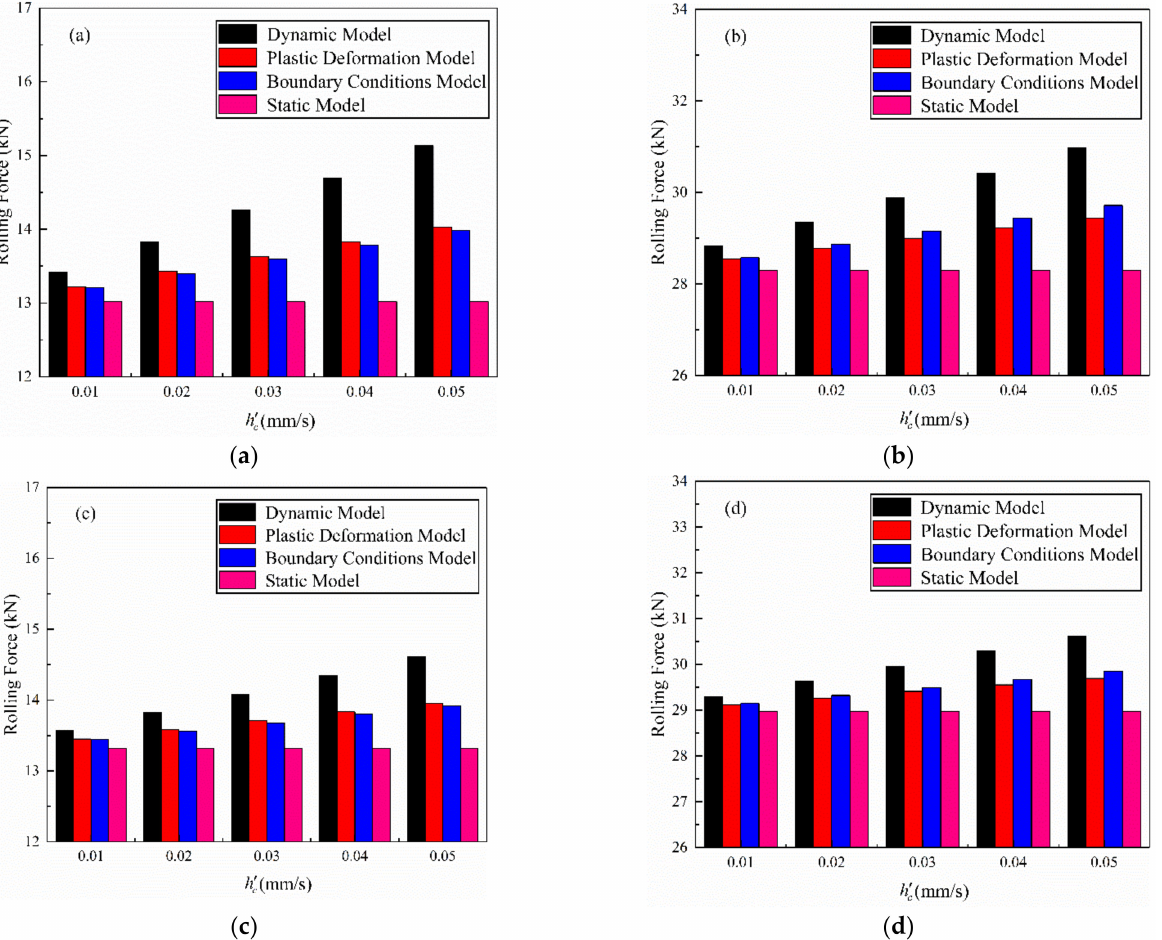
Figure 13. The contribution of the average metal deformation rate and dynamic boundary conditions to the dynamic rolling force value. The strip exit thickness and rolling velocity are respectively: ( a ) 1.816 mm, 12.5 mm/s; ( b ) 1.57 mm, 12.5 mm/s; ( c ) 1.816 mm, 20.5 mm/s; ( d ) 1.57 mm, 20.5